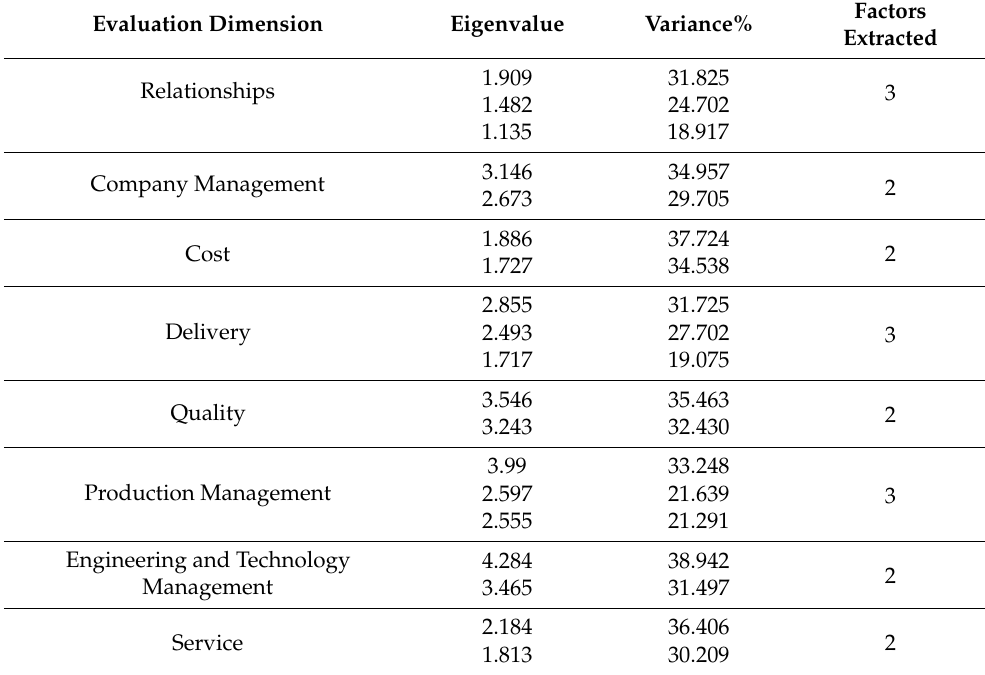
Table 2. Summary of the exploratory factor analysis results for the